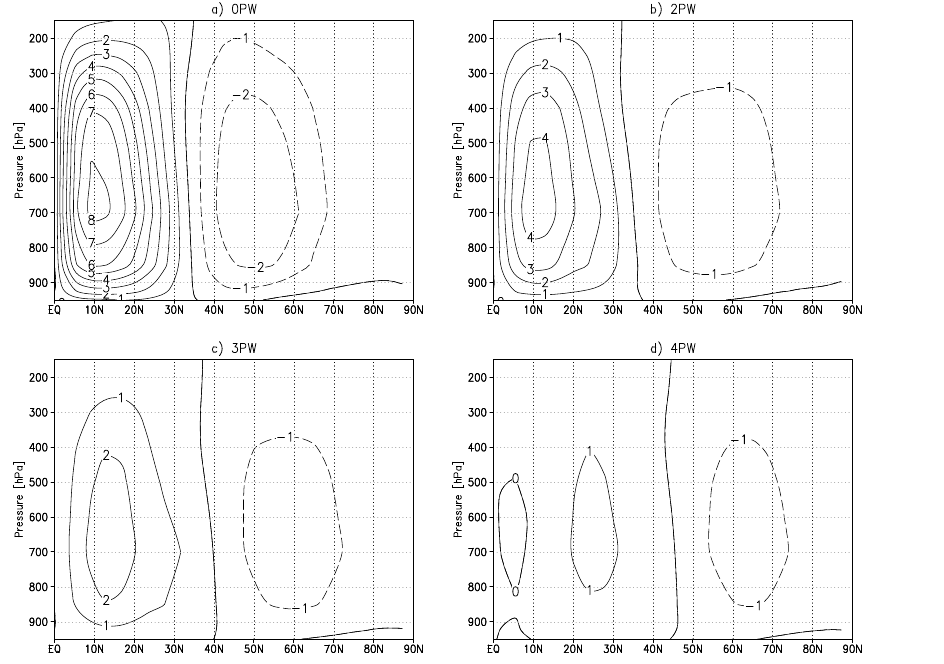
Figure 12. Climatological annual mean mass stream function (in 10 10 kgs − 1 ) for OHT max = 0, 2, 3, and 4PW.